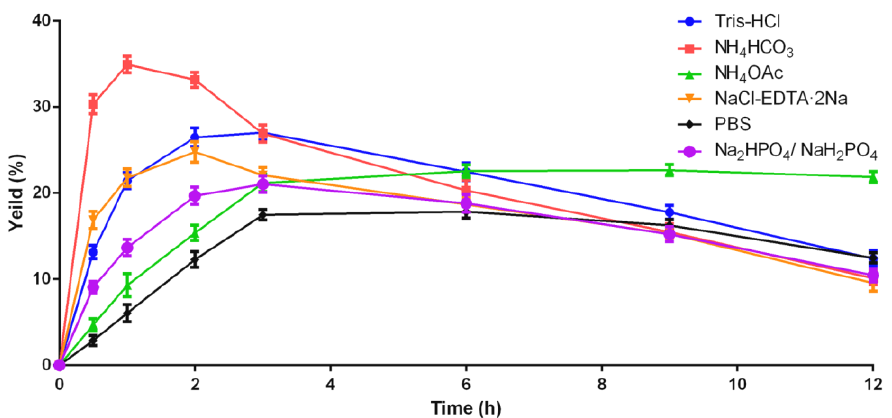
Figure 4. Yields of folded Lv32.1 in different buffers with diverse concentrations of GSH/GSSG for 1 h .